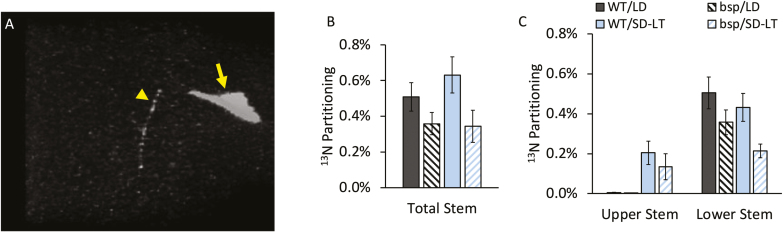

13N partitioning in poplars during SD-induced BSP accumulation. (A) PET image of 13N distribution in a representative poplar plant. 13NH3 was fed to the load zone (yellow arrow), the portion of the load leaf clamped inside a leaf cuvette, and the plant was imaged 1 h later. The arrowhead points to 13N labeling in the stem. (B) 13N partitioning in wild-type (WT) and BSP RNAi (bsp) poplar stems, and (C) 13N partitioning separated into the regions of the stem below the load leaf (lower stem) and above the load leaf (upper stem). Plants were grown in a long-day photoperiod (LD), or grown first in LDs followed by 6 weeks in a short-day photoperiod plus another 3–5 weeks in SDs and low temperature (SD-LT). Bars indicate the mean ±SE 13N partitioning to the stem as a percentage of total 13N in the plant.